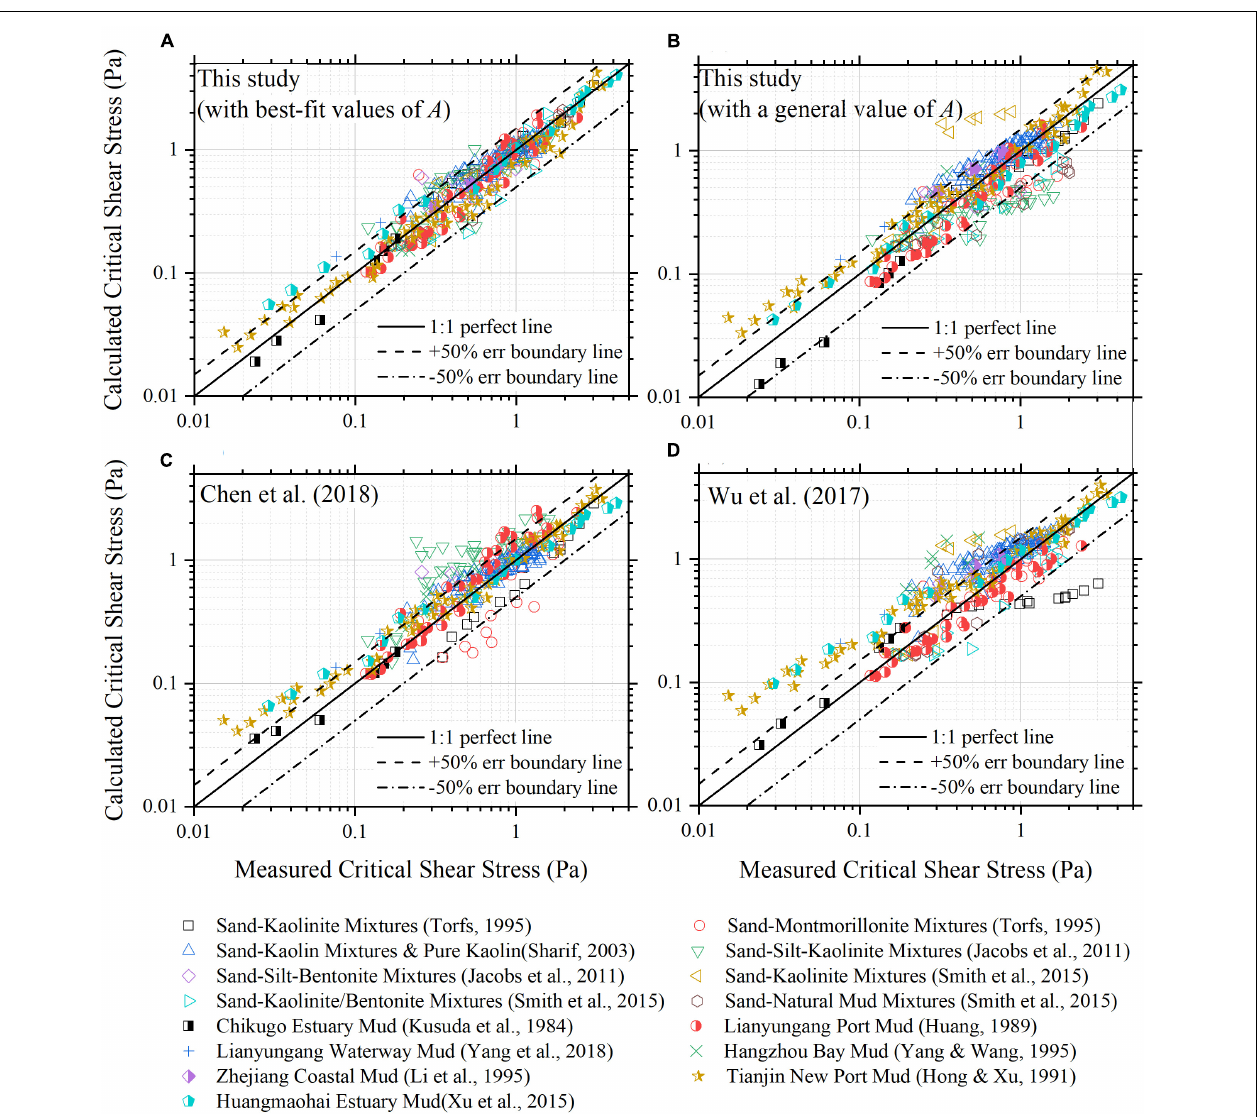
FIGURE 9 | The comparisons of the calculated and measured critical shear stresses in the collected datasets: (A) Eq. (23) (in which the best-fit value of A is used for each dataset), (B) Eq. (23) (in which a constant value of A is used for all the datasets: 3.97 × 10 − 6 J m − 2 ), (C) the formula of Chen et al. (2018), and (D) the formula of Wu et al.